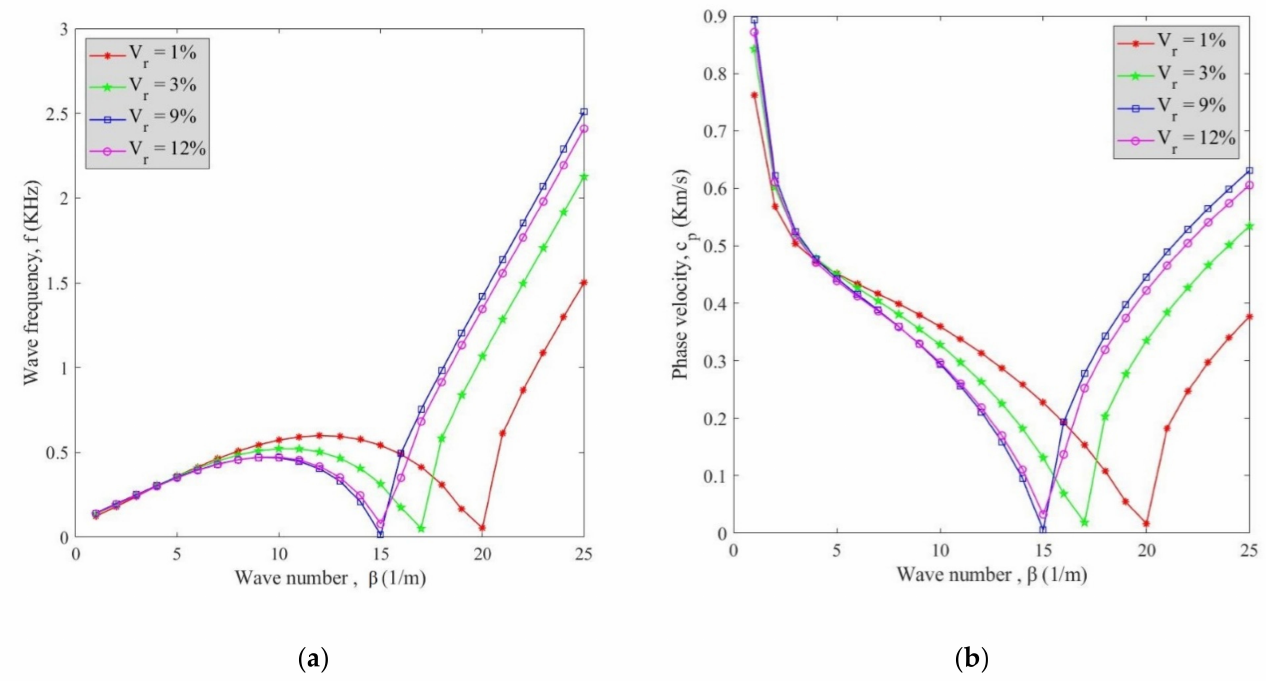
Figure 4. Variation of ( a ) wave frequency and ( b ) phase velocity versus wave number for various volume fraction of